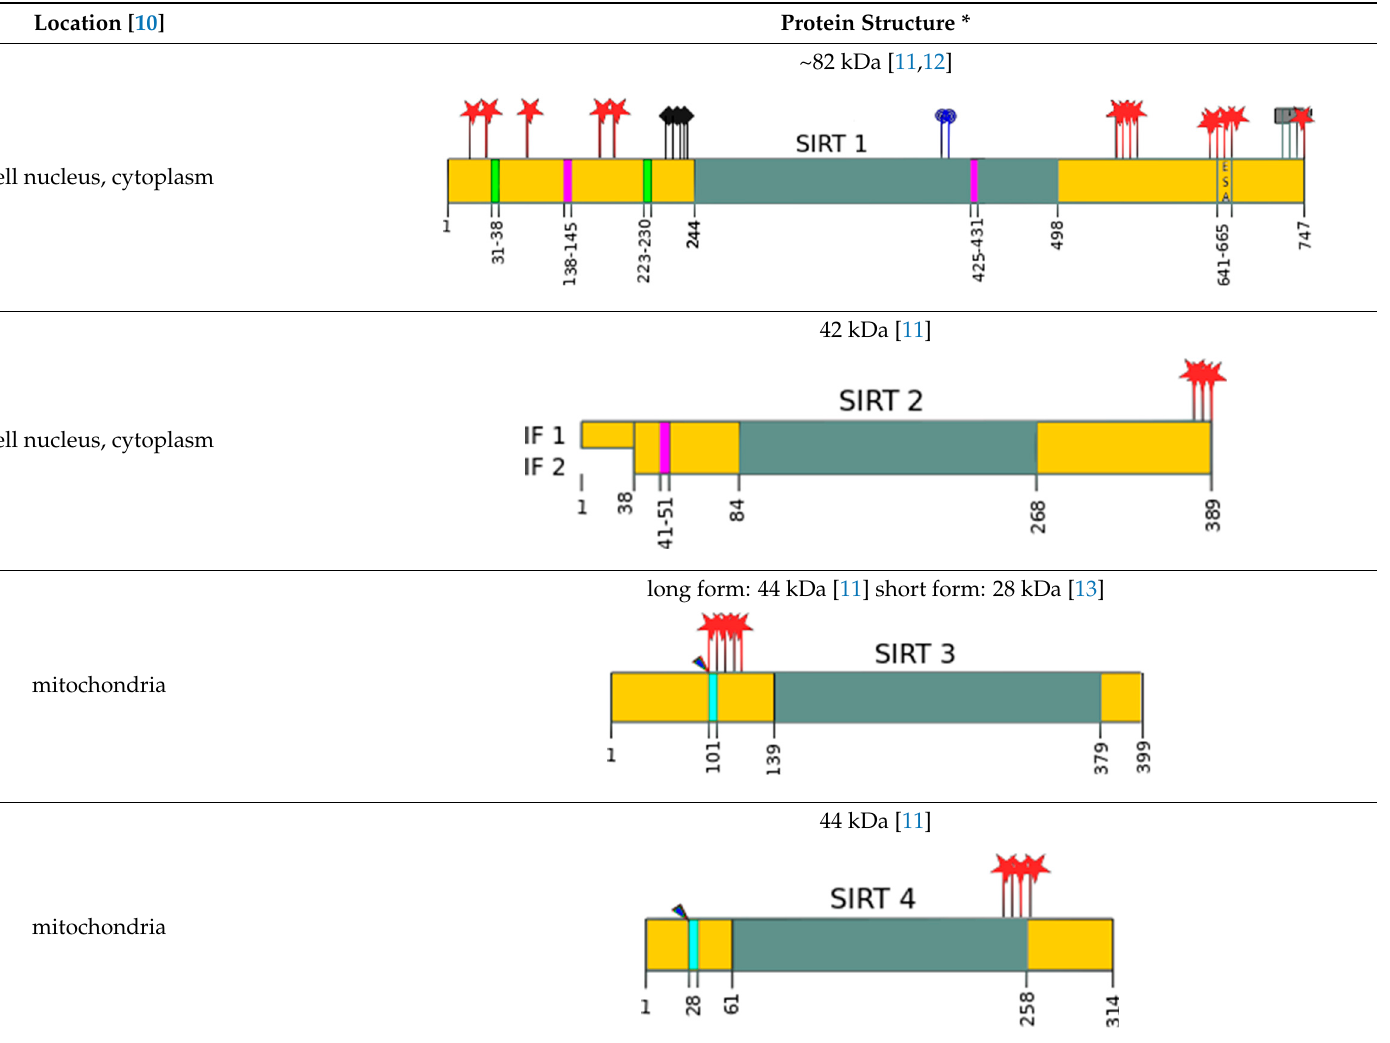
Table 1. Human SIRTs—structure and target location.